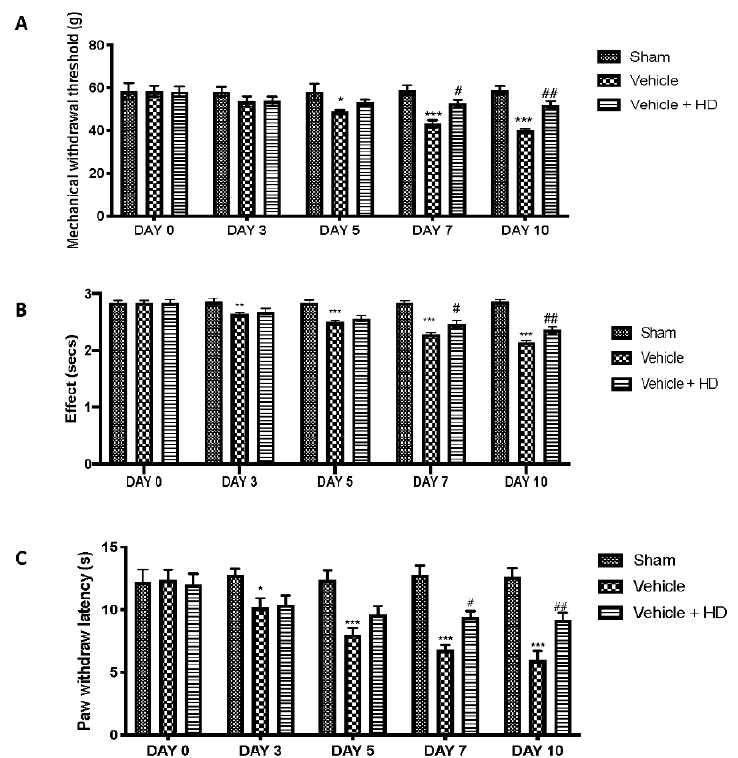
Figure 3. Effect of HD on mechanical and thermal hyperalgesia: von Frey hair ( A ) hot plate ( B ) and tail-flick warm water ( C ) tests. * p < 0.05 vs. sham; ** p < 0.01 vs. sham; *** p < 0.001 vs. sham; # p < 0.05 vs. vehicle; ## p < 0.01 vs. vehicle; ### p < 0.001 vs. vehicle.